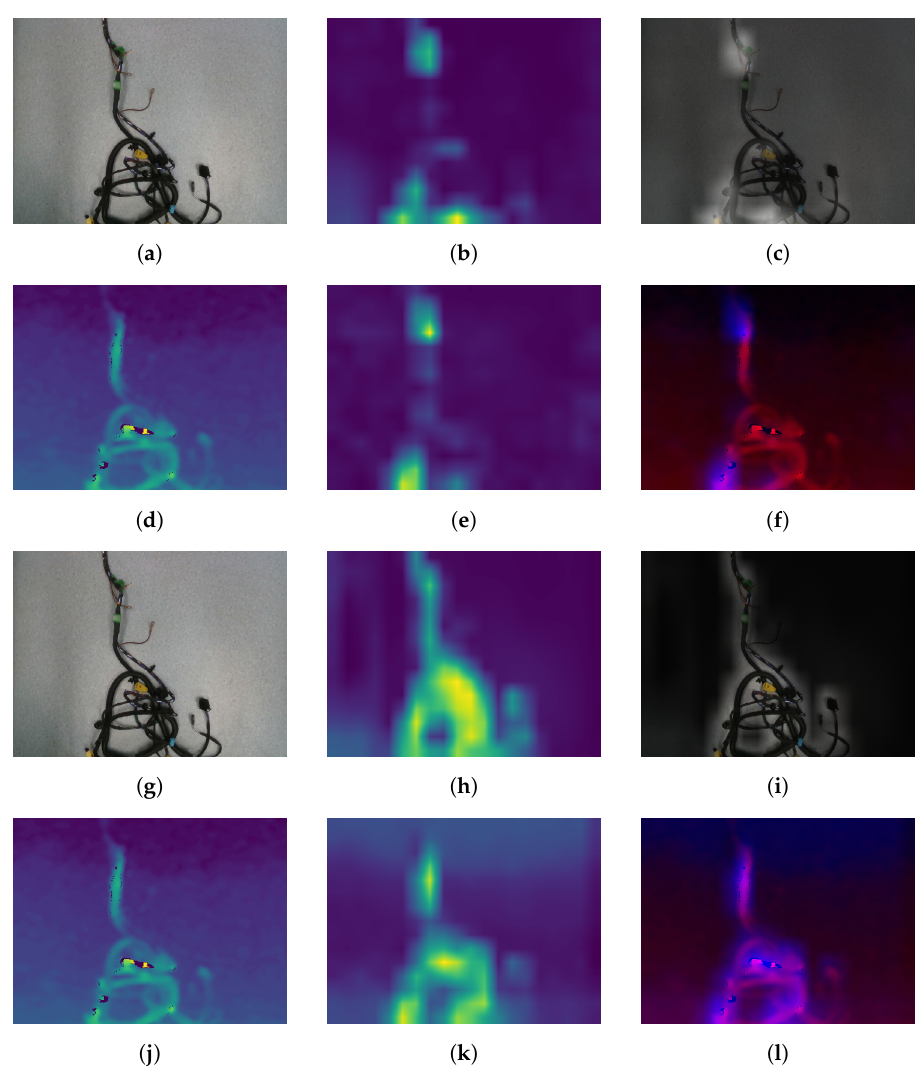
Figure 6. Class agnostic saliency maps generation method applied to the RGB + Depth (1st and 2nd row) and RGB + Depth + DA (3rd and 4th rows) models on the image of wiring harness from the validation dataset (fold I, III/II). Images from first column represents the input data: ( a , g )—RGB image, ( d , j )—depth data. In the second column, there are generated saliency maps, computed with the method described in Section 3.4, while in the last column, the input images with saliency maps superimposed on them. For the depth images, we changed the color scheme in the last column, such that the depth is represented by the intensity on the red channel, while the saliency is represented in the blue